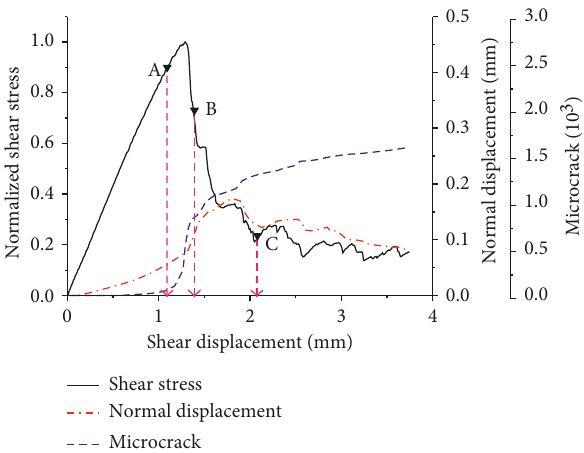
Figure 13: Shear curves of Sample B0.